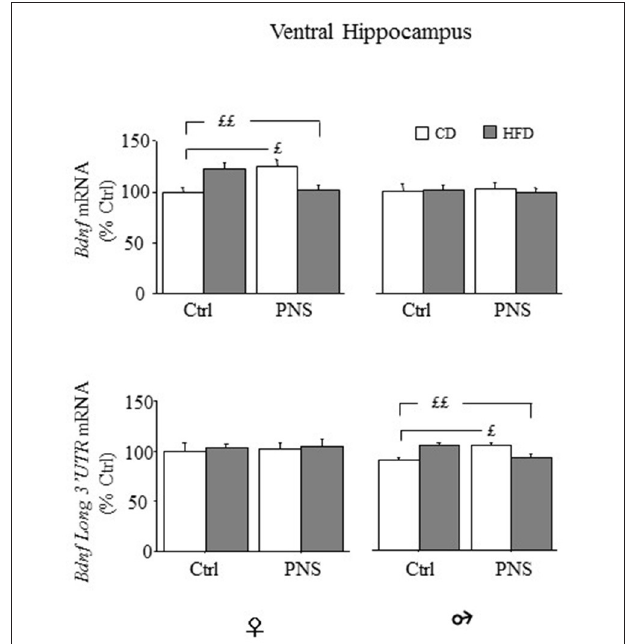
FIGURE 6 | Bdnf mRNA expression in the ventral hippocampus of female and male offspring. Relative mRNA levels (% ctrl) of total Bdnf (upper panel) and of Bdnf long 3 ′ UTR mRNA (lower panel). In females both PNS and HFD increased total Bdnf mRNA while exposure to PNS in HFD-fed rats prevented this increase (Ctrl-HFD vs. Ctrl-CD and PNS-HFD; PNS-CD vs. Ctrl-CD). Comparable effects can be observed in male rats for the levels of Bdnf long 3 ′ UTR (Ctrl-HFD vs. Ctrl-CD and PNS-HFD; PNS-CD vs. Ctrl-CD). Data are shown as mean + SEM. ££ p < 0.01 £ p < 0.05, interaction between Prenatal Condition and Diet.